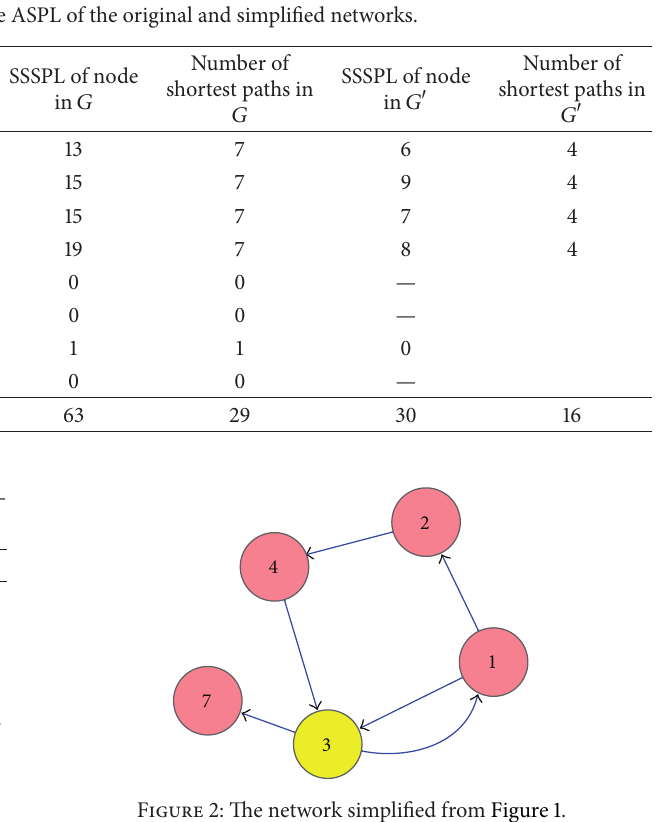
Figure 2: The network simplified from Figure